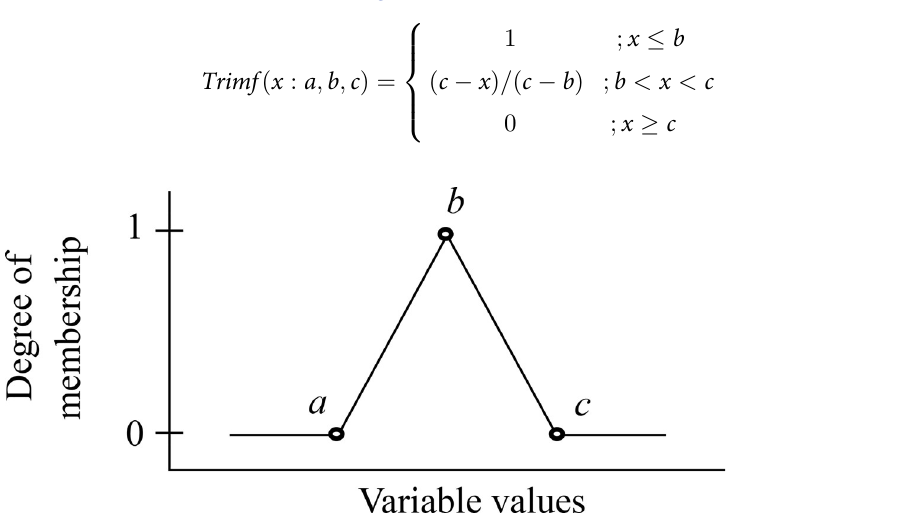
Fig 5. The full triangular membership